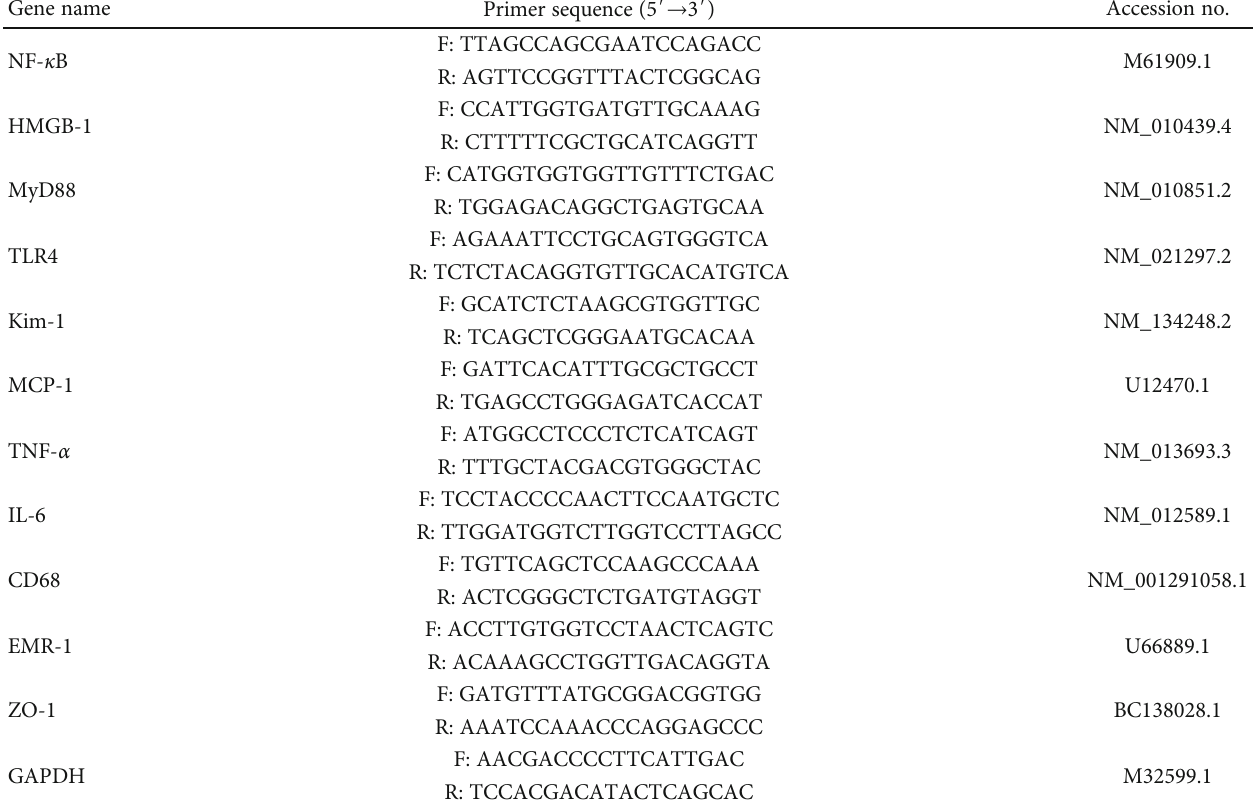
Table 2: Sequences of oligonucleotide primers used for PCR ampli fi